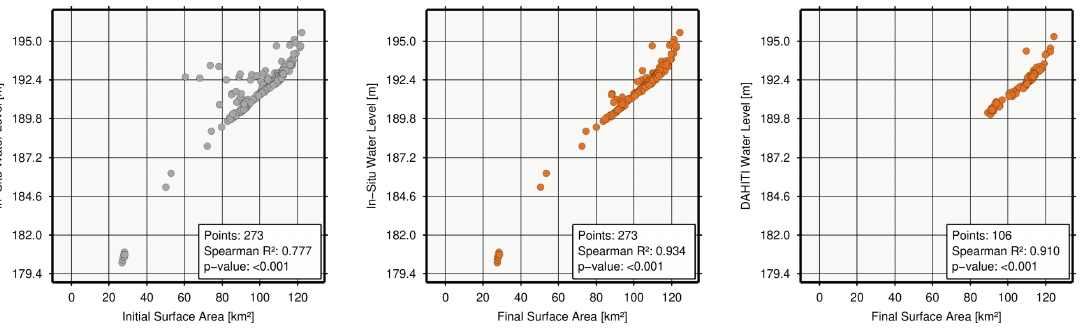
Figure 14. Validation of surface area time series for Lake Ray Roberts using water levels from in situ stations and satellite altimetry. The improvement of our new approach is shown by comparing initial surface areas with data gaps ( left ) and final filled surface areas ( middle , right